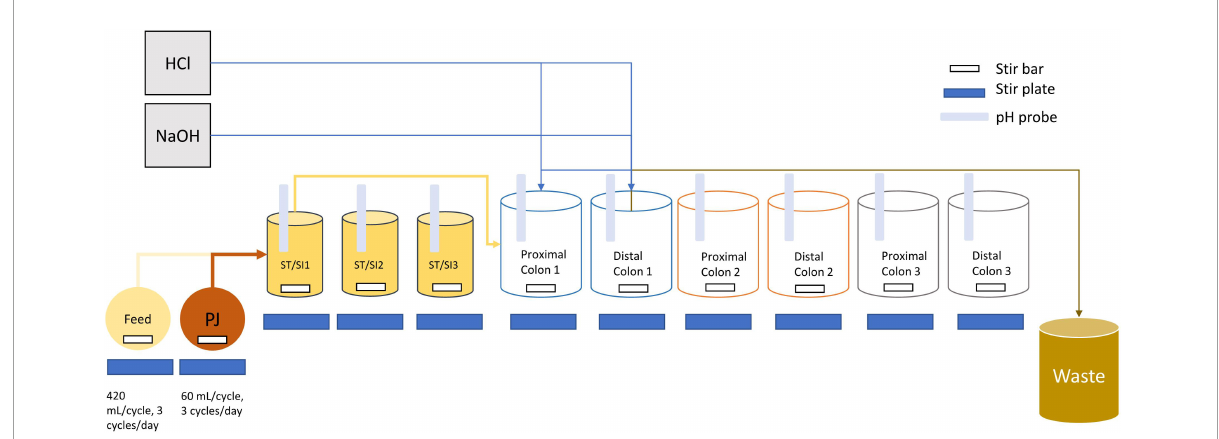
FIGURE1 Schematic diagram of the infant triple SHIME. Tubing connections are only shown for SHIME 1 as an example, but SHIME 2 and 3 are connected in the same manner. Each SHIME compartment had one stomach/small intestine (ST/SI), proximal and distal colon vessel. Feed and contents from the proximal colon were transferred into each of the ST/SI vessels three times a day. Contents from the ST/SI vessels are then transferred into the proximal colon while contents from the proximal colon were transferred into the distal colon. HCl and NaOH were added into the vessels as needed to maintain a uniform pH range. Contents from the distal colon were transferred into a waste bucket for disposal. All vessels were kept at 37 ◦ C and consistently flushed with nitrogen to maintain an anaerobic environment. PJ refers to pancreatic juice.